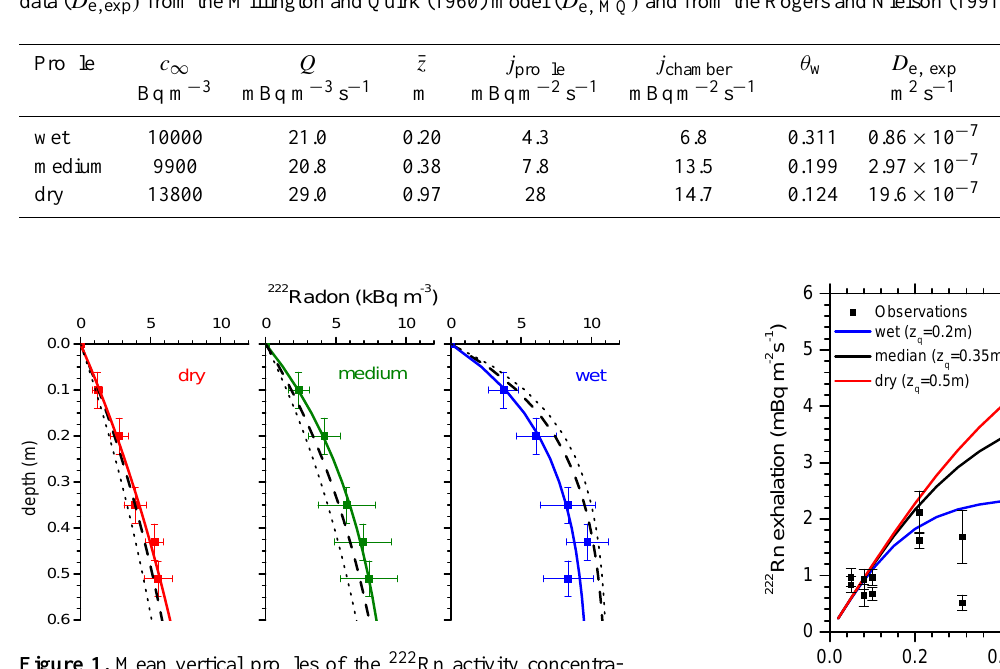
Table 1. Parameters of the fit curves plotted in Fig. 1, mean exhalation rates estimated from the measured radon concentration profiles ( j profile ) and directly measured with flux chambers ( j chambers ) at the same site, as well as mean diffusivity as estimated from the experimental data ( D e,exp ) from the Millington and Quirk (1960) model ( D e, MQ ) and from the Rogers and Nielson (1991) model ( D e, RN ) .